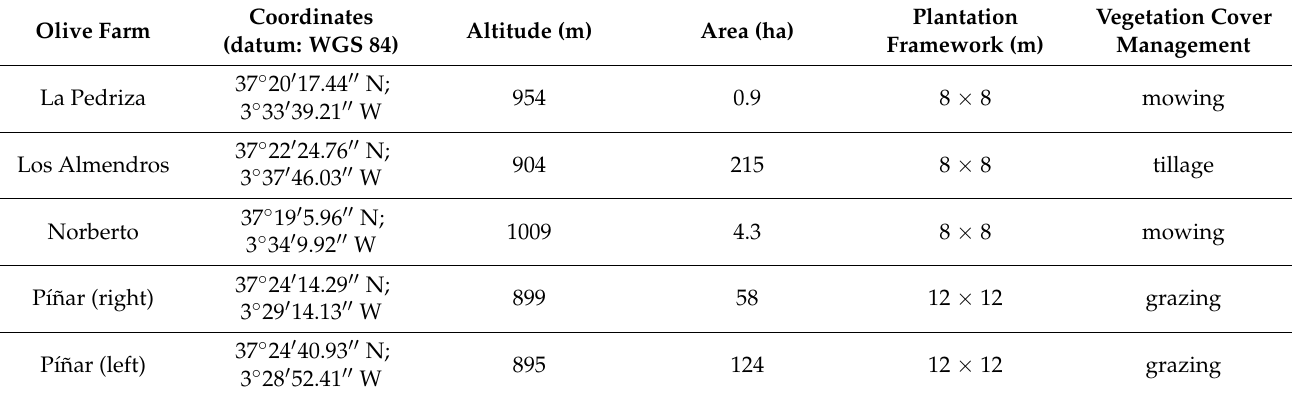
Table 1. Characteristics of the studied olive farms: geographical parameters, altitude, surface area, plantation framework and vegetation cover